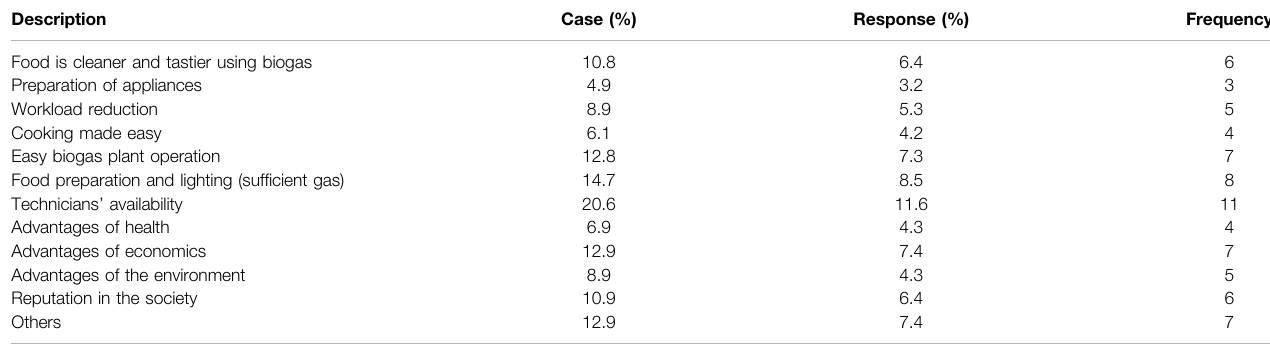
TABLE 7 | Satisfaction and views of biogas plant users.